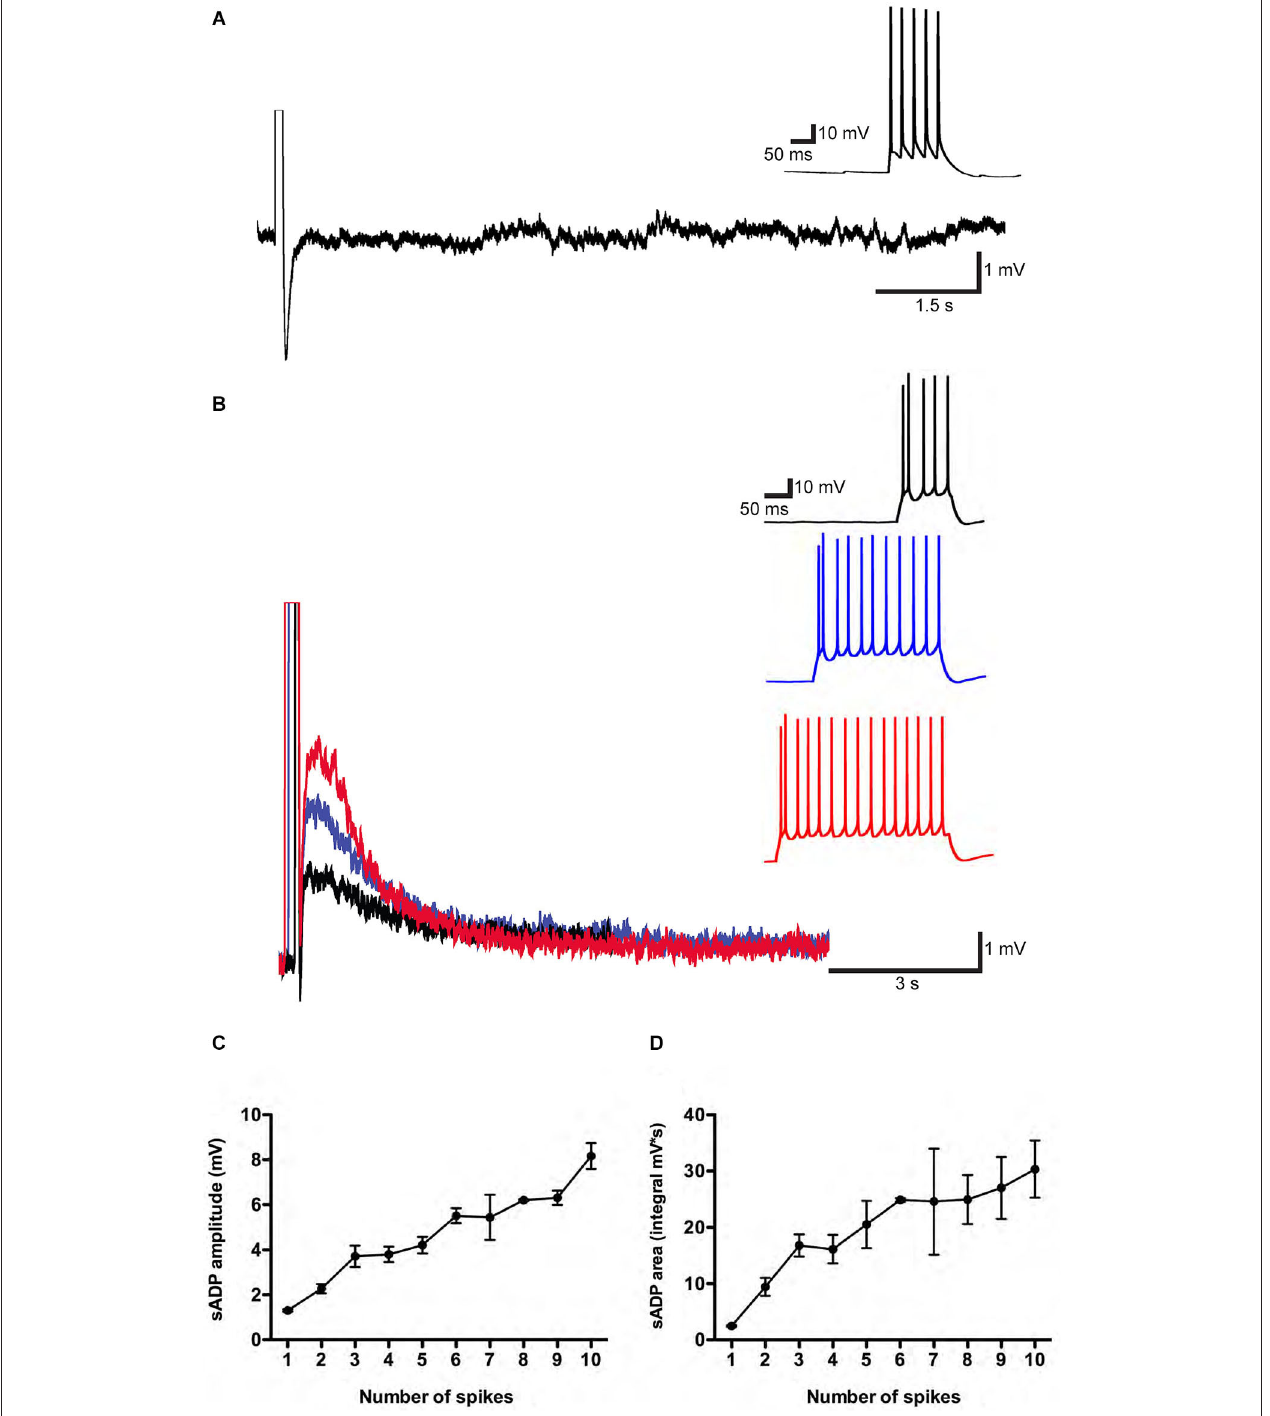
response to 200 pA depolarizing current steps of increasing duration (black trace: 100 ms; blue trace: 300 ms; red trace: 400 ms). Insets show action potential firing during the depolarization. Initial V m was − 65 mV. (C) and (D) Input-output relations plotting sADP amplitude and area as a function of the number of action potentials elicited by increasing amounts of depolarizing charge injection in the presence of CCh. n = 4–8 for each